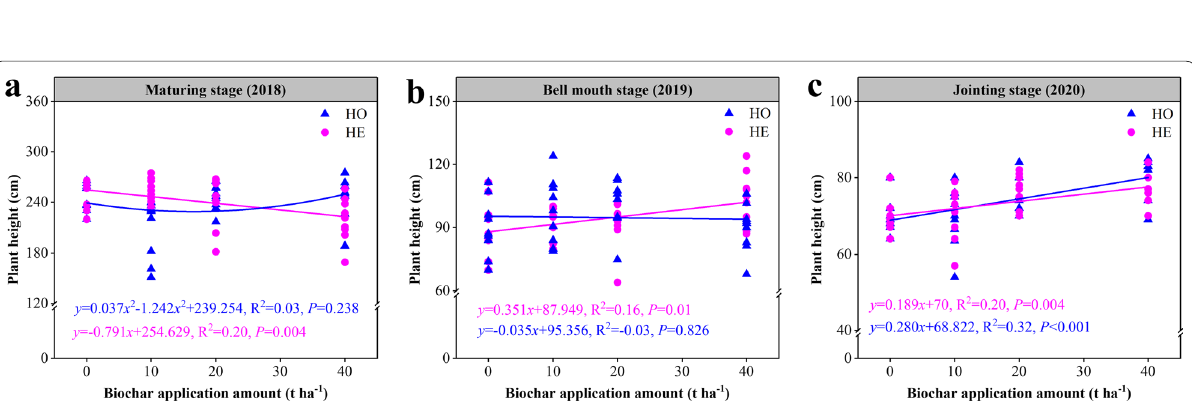
Fig. 5 The relationship between plant height and biochar application amount. a The relationship between plant height and biochar application amount at maturing stage in 2018. b The relationship between plant height and biochar application amount at bell mouth stage in 2019. c The relationship between plant height and biochar application amount at jointing stage in 2020. HO, homogeneous application; HE, heterogeneous